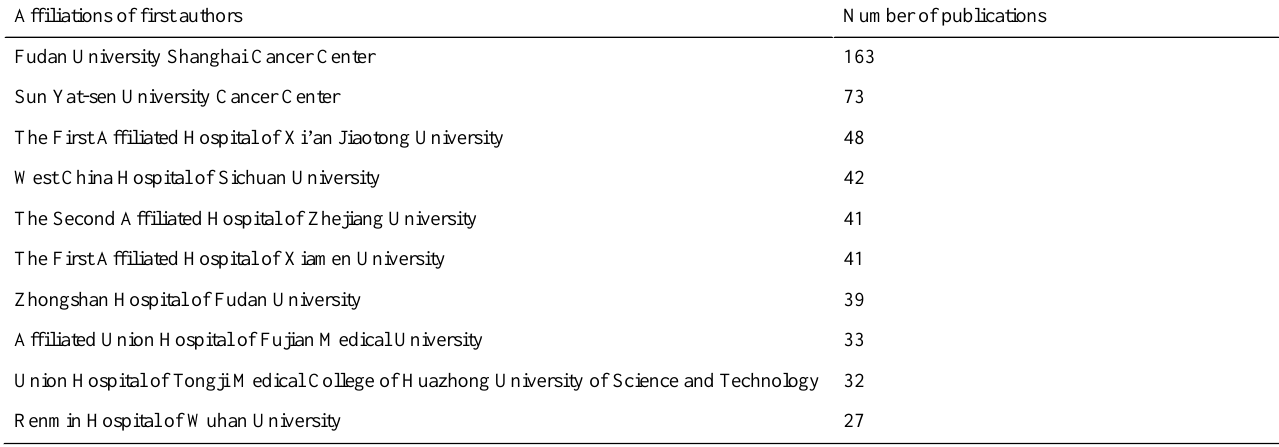
Table 2. Top 10 affiliated organizations of the most contributing first